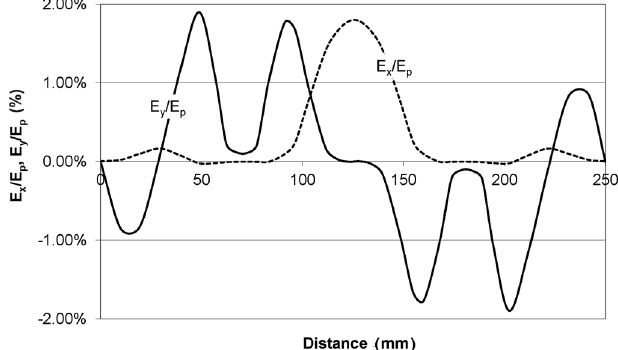
SLR.FIG. 10. MWS E -field distribution along the axis of the 150 MHz